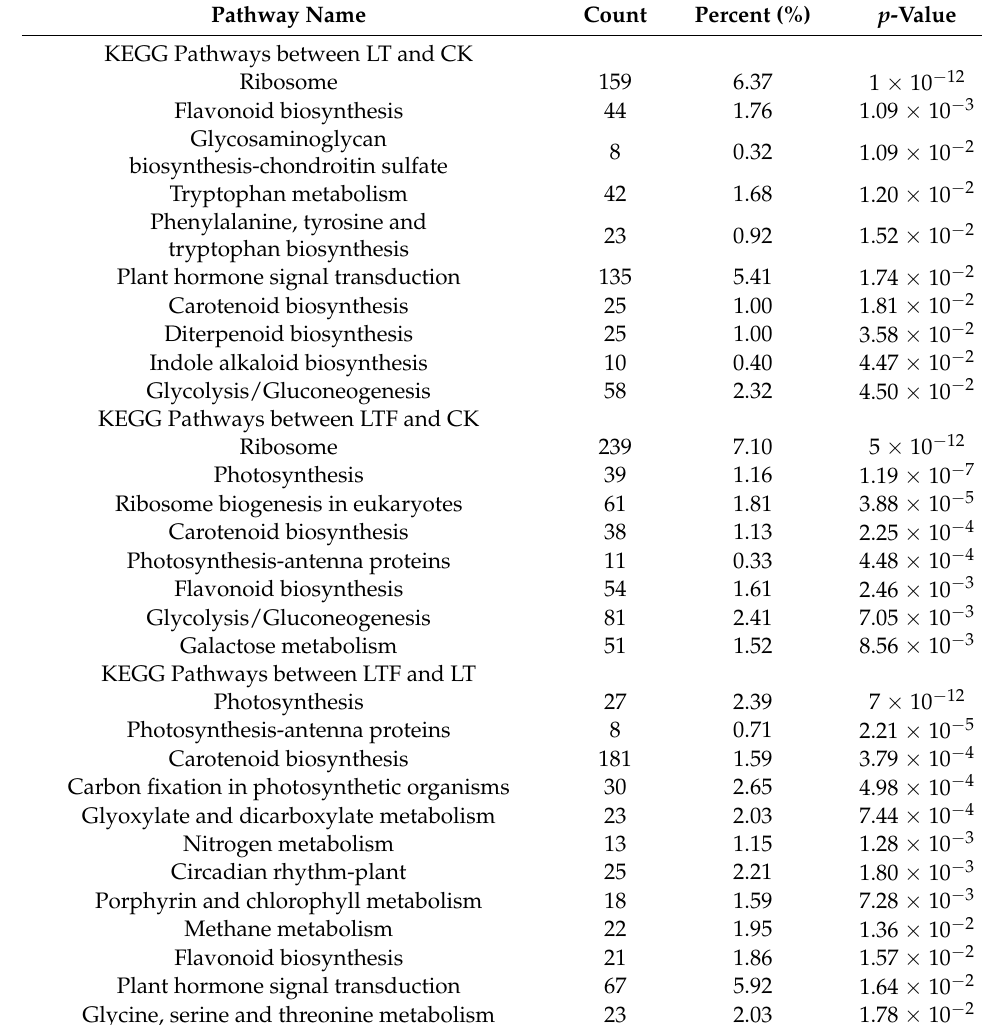
Table 4. KEGG pathway enrichment analysis of DEGs between LT, LTF and